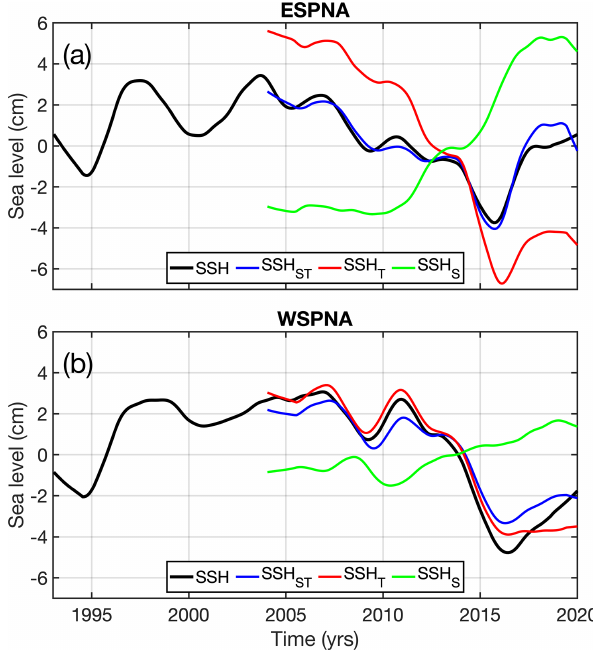
Figure 7. Time series of SSH (black), SSH ST (blue), SSH T (red), and SSH S (green) averaged over (a) 0–30 ◦ W and 55–65 ◦ N in the eastern SPNA (ESPNA) and (b) 30–60 ◦ W and 53–65 ◦ N in the western SPNA (WSPNA) (the areas of ESPNA and WSPNA are shown in Figs. 1 and